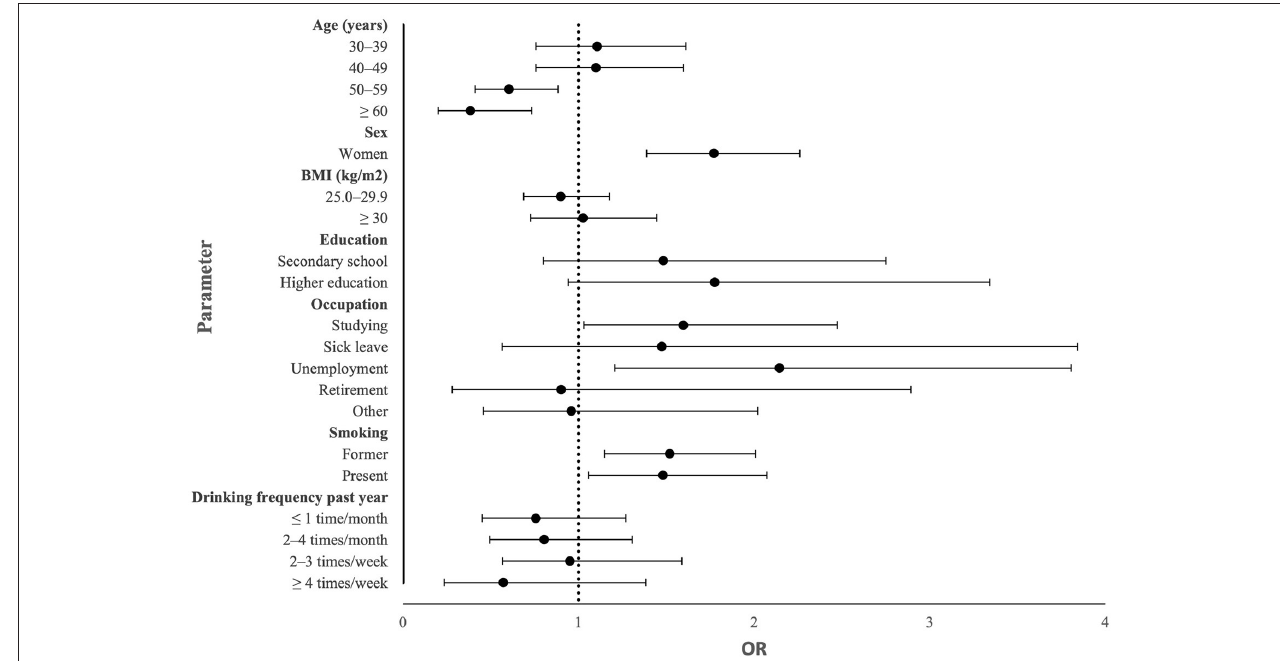
FIGURE 3 | Forest plot showing odds ratio (OR) and 95% confidence interval in an adjusted model calculating sociodemographic parameters significantly associated with gastrointestinal symptoms in crude